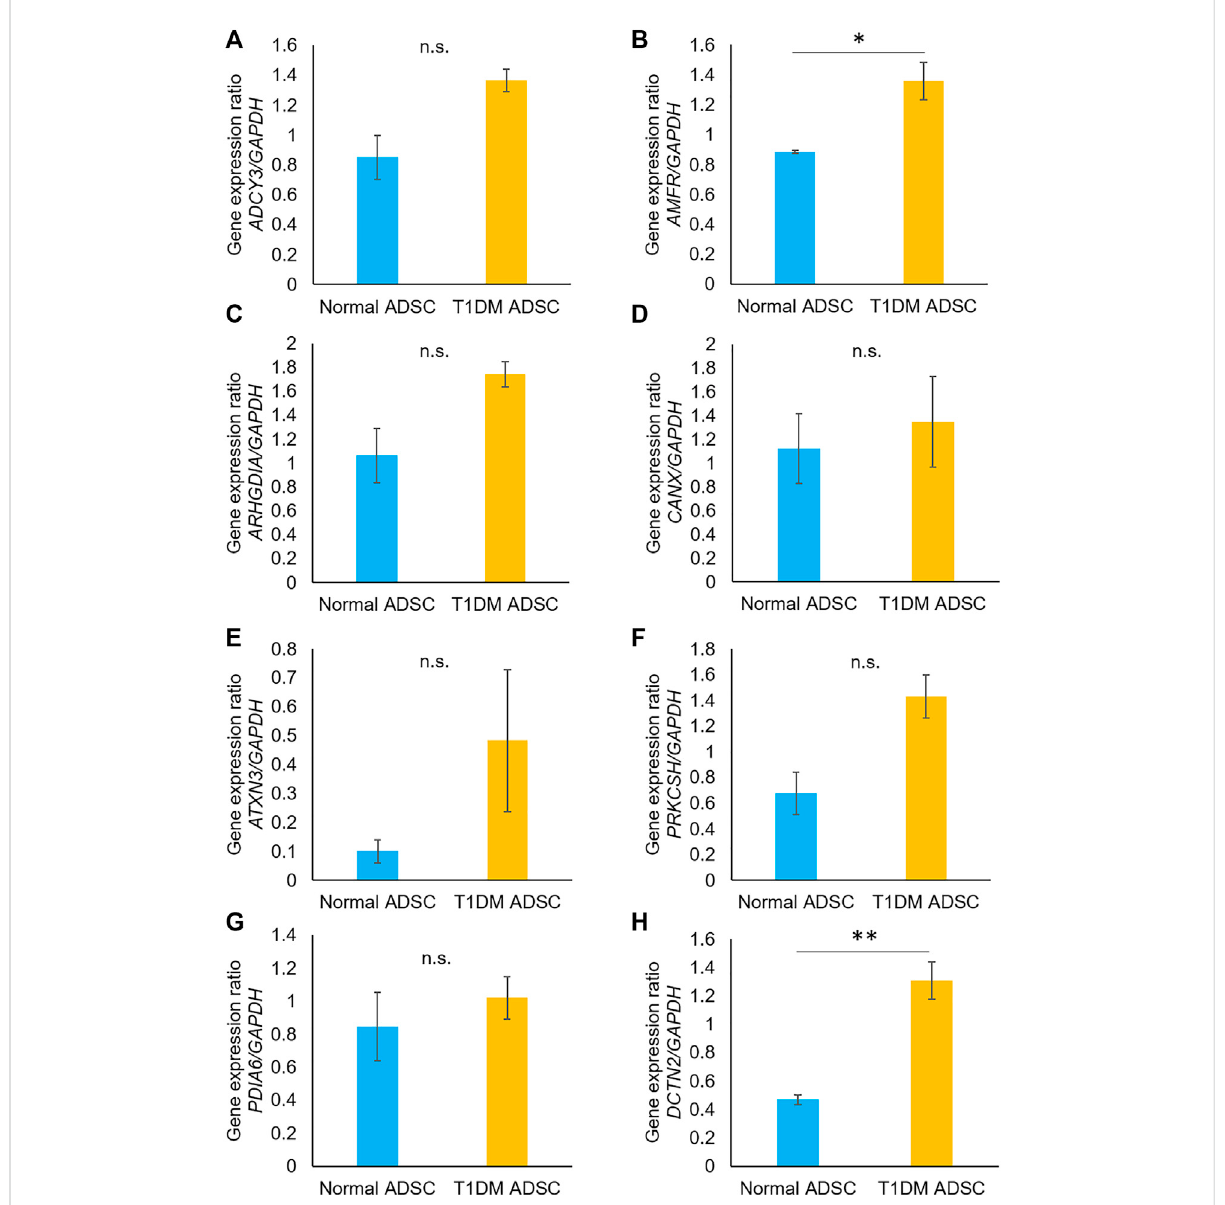
FIGURE 2 Gene expression analysis using quantitative PCR on human adipose tissue-derived mesenchymal stem cells. The gene expression of the eight genesidenti fi edinnext-generationsequencingwasevaluatedbyquantitativePCR.Thegenevariationgraphsweremarkedforeachgene (A) ADCY3 , (B) AMFR , (C) ARHGDIA , (D) CANX , (E) ATXN3 , (F) PRKCSH , (G) PDIA6 , (H) DCTN2 . Gene expression was expressed as a ratio to the housekeeping gene GAPDH. The light blue bars present values for normal ADSC, and the orange bars show values for T1DM ADSC. Three